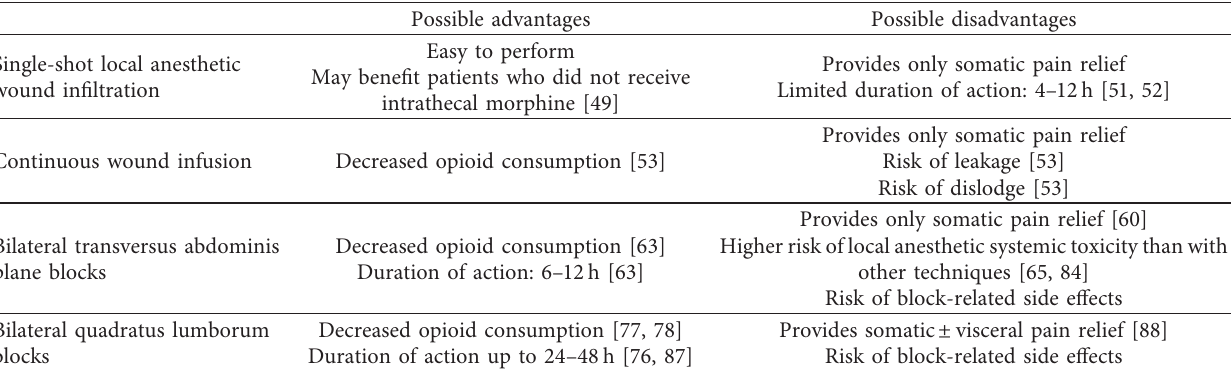
Table 2: Comparison efficacy of regional anesthetic techniques on analgesic